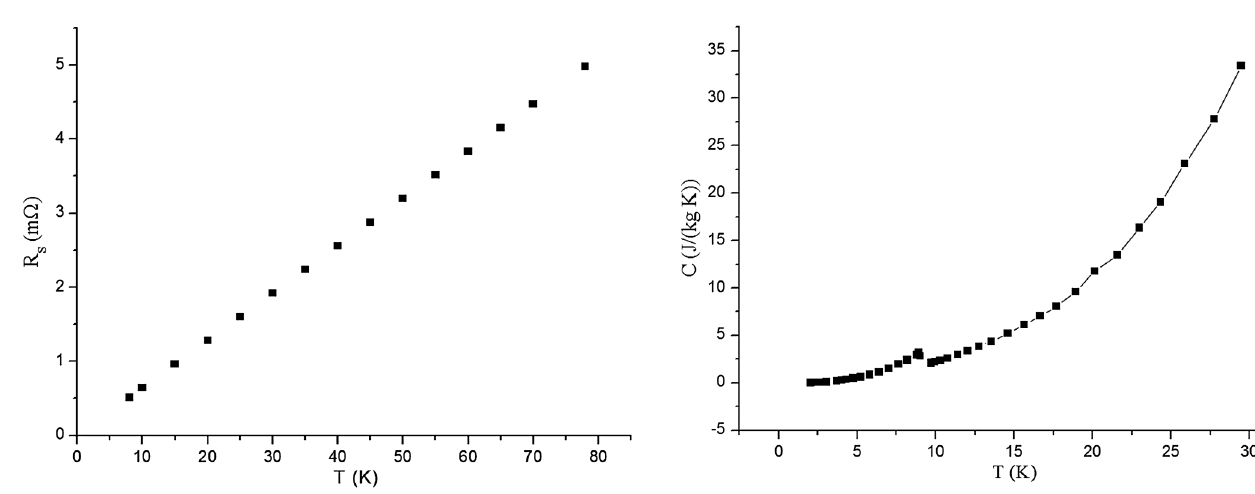
FIG. 7. Capacity of